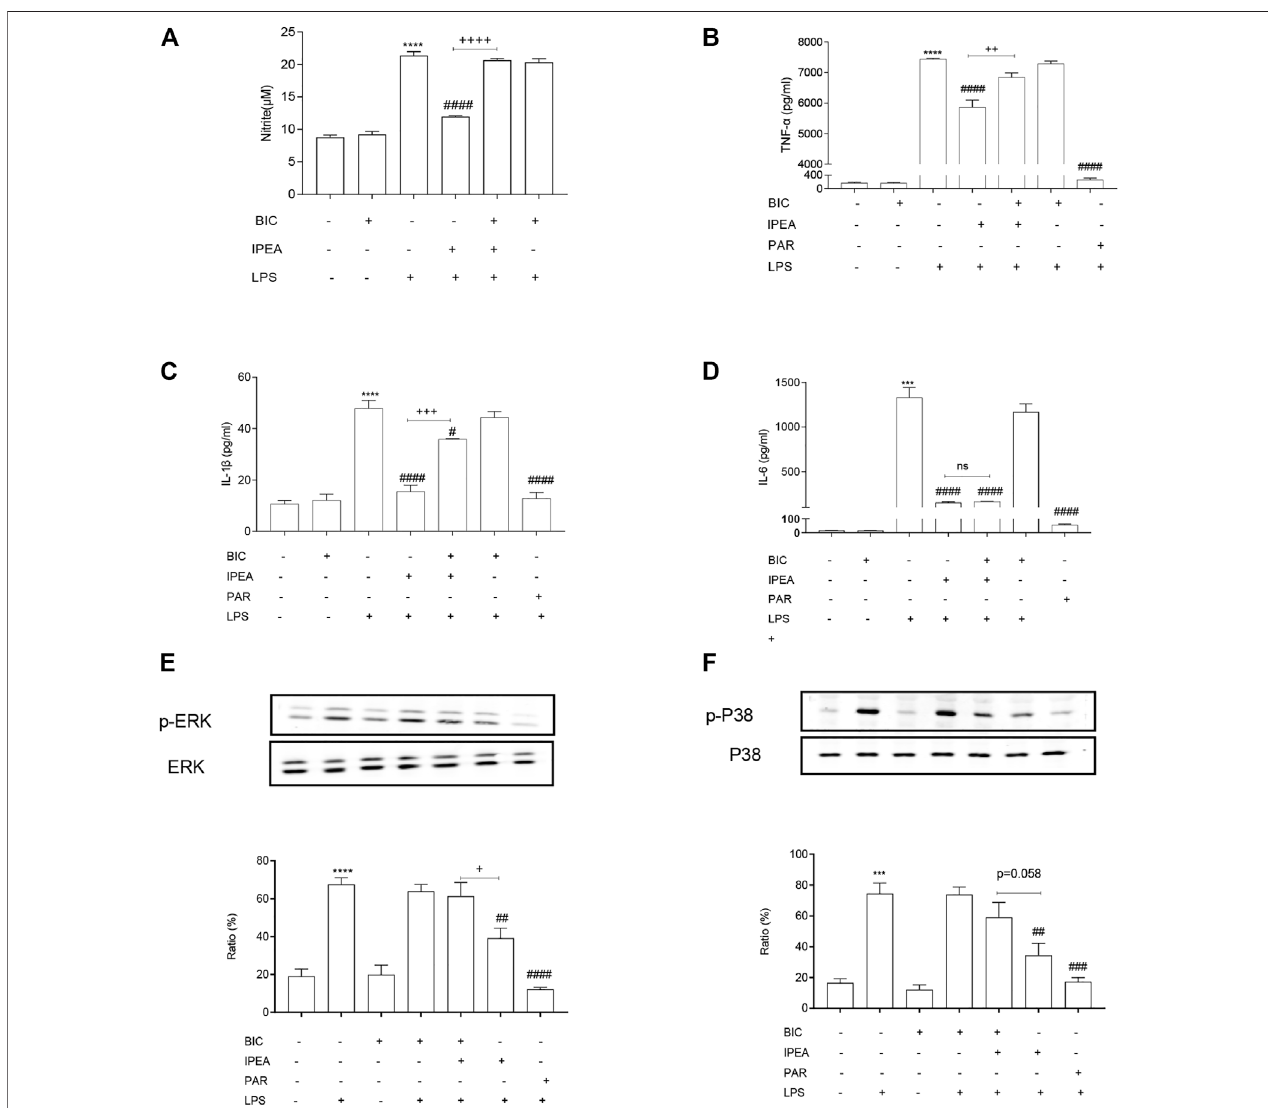
FIGURE5 | IPEA exerts anti-in fl ammatory effectvia GABA A Rin LPS stimulated RAW 264.7 macrophagecells. (A) EffectsofBIC on IPEA-induced suppression on NOproduction.CellswerepretreatedwithBIC(1 μ M)for10min,followedby1-hIPEA(10 μ g/ml)treatmentandthenstimulatedwithLPS(100 ng/ml)for23 h.Thenitrite level was determined by Griess reagent. (B – D) Effects of BIC on IPEA-induced suppression on the expression levels of in fl ammatory cytokines. The protein expression levels of TNF- α (B) , IL-1 β (C) and IL-6 (D) were determined by ELISA according to manufacturer ’ s instructions. Cells were pretreated with BIC (1 μ M) for 10 min, followedby1-hIPEA(10 μ g/ml)treatment,and thenstimulated withLPS(100 ng/ml)for4 h. (E,F) Effects ofBIConIPEA-inducedsuppressiononsignaling pathwaysof MAPKs. Phosphorylated ERK ( p -ERK) (E) , and P38 (p-P38) (F) , were determined by Western blot and normalized to the total ERK and P38 expression levels, respectively. Cells were pretreated with BIC (1 μ M) for 10 min, followed by IPEA (10 μ g/ml) treatment for 1 h, and then stimulated with LPS (100 ng/ml) for 30 min. PAR (parthenolide, 10 μ M) was used as positive control. One-way ANOVA followed Tukey test was used for data analysis. The data were obtained from three